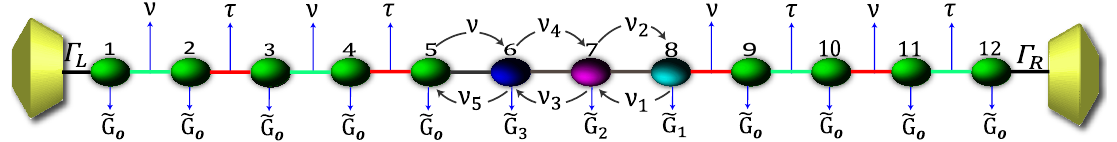
Figure A3. Renormalized 2,7-Di([1,1 (cid:48) -biphenyl]-4-yl)-9H-fluorene molecular